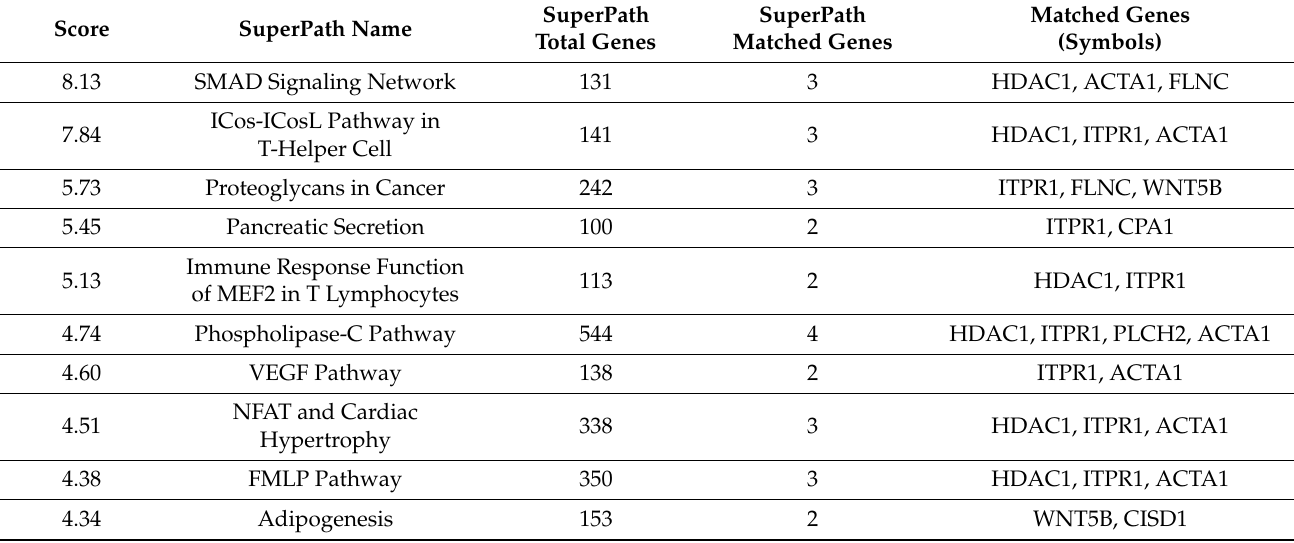
Table 5. Significantly enriched pathways 1 for breaking strength